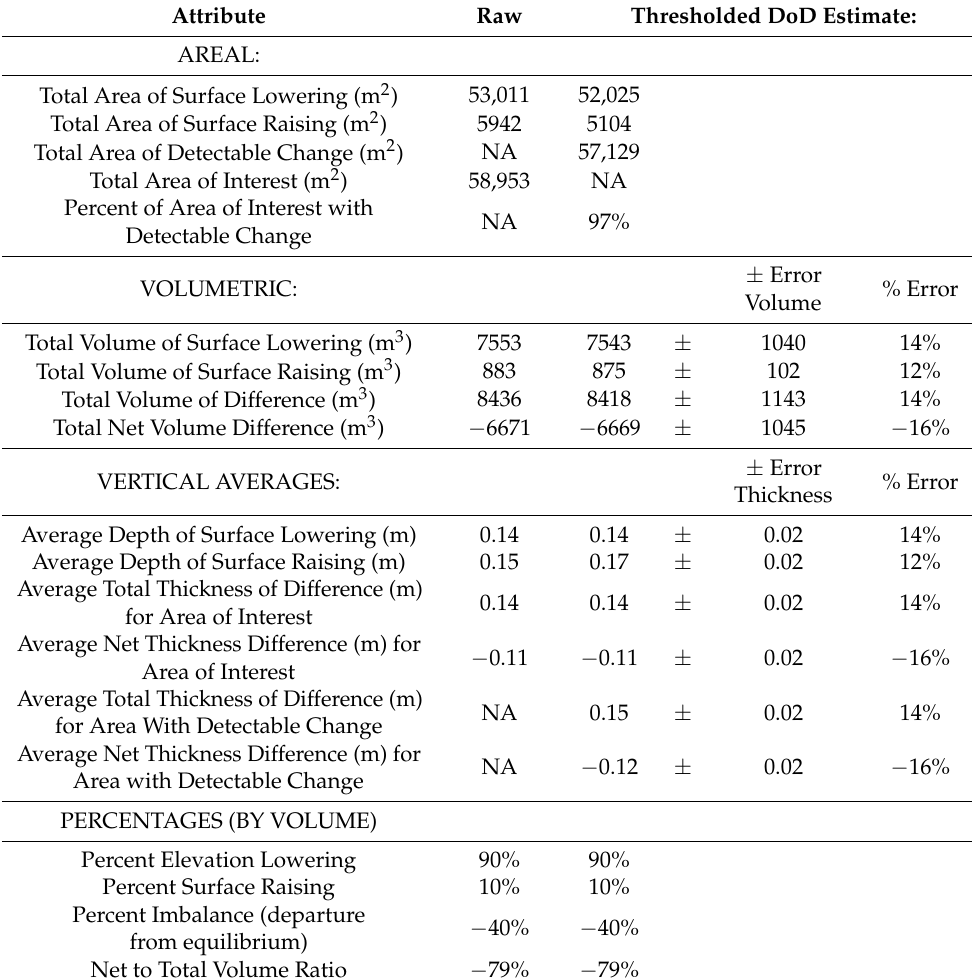
Table 4. Geomorphic changes in the Scott River alluvial fan area of interest from July 2010 during the August 2013 flood event calculated using the DoD method in GCD software. Uncertainty was calculated using a minimum detection level (minLoD) of 0.02